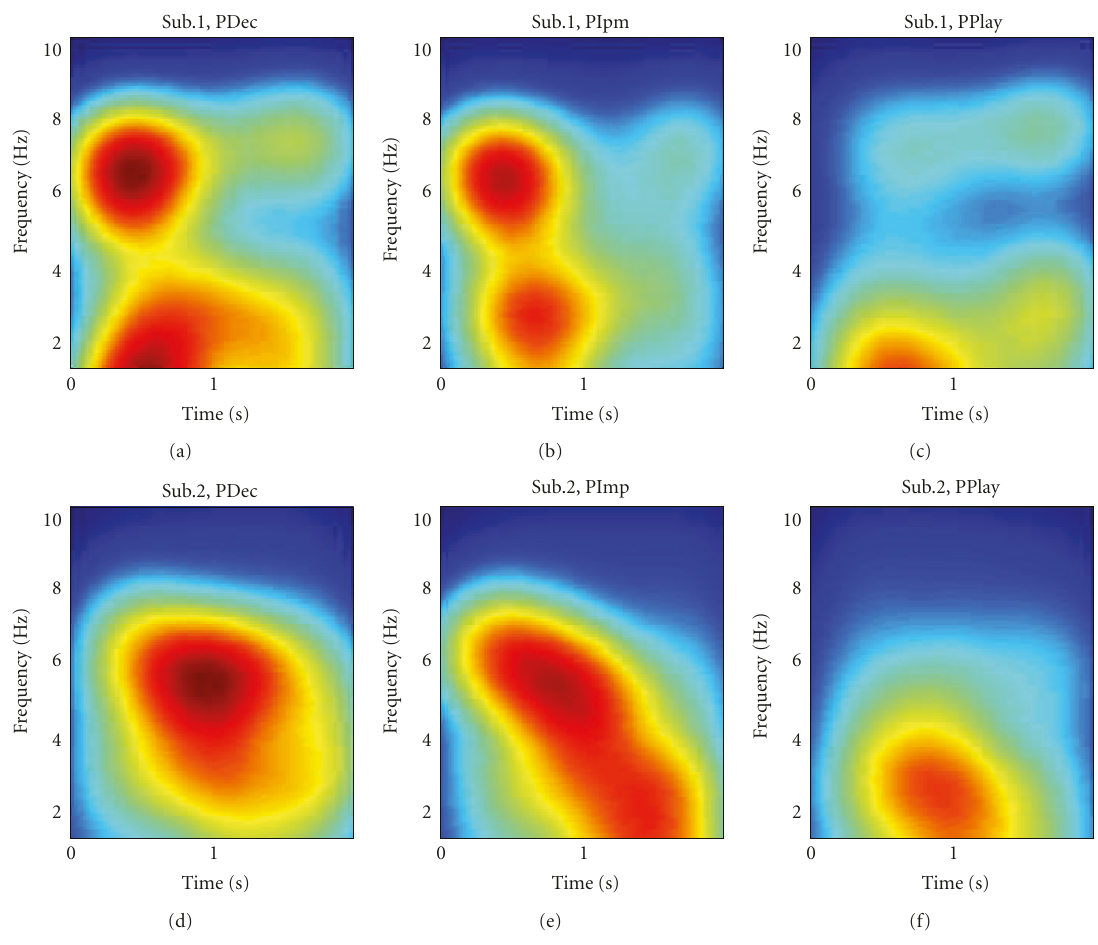
Figure 11: Multitaper spectrogram estimation of induced potentials from Protodeclarative (PDec), Protoimperative (PImp) and Neutral Parallel Play (PPlay) shows, using N = 256, F s = 12, c = 20 and δ = 0 . 05. The number of averaged power responses are for subject 1, 20 and for subject 2,